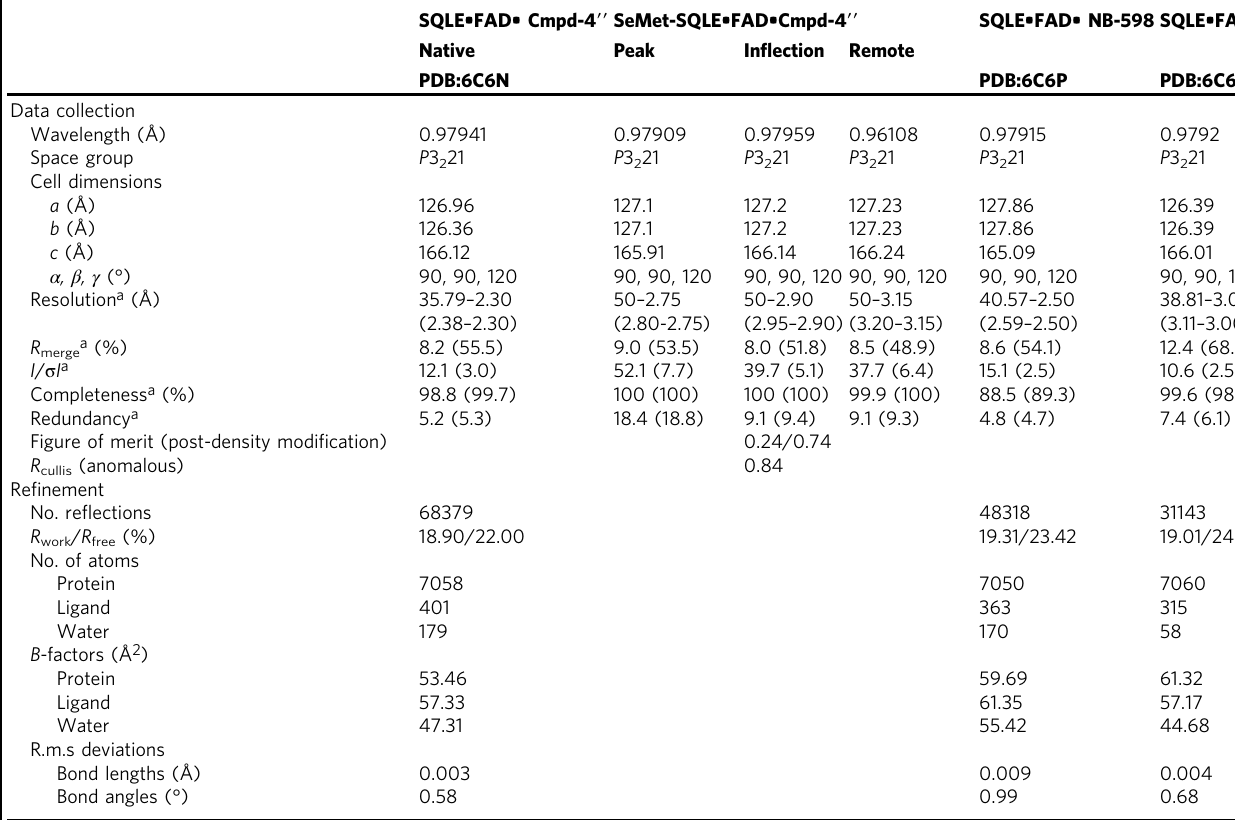
Table 2 X-ray data collection, phasing, and re fi nement statistics